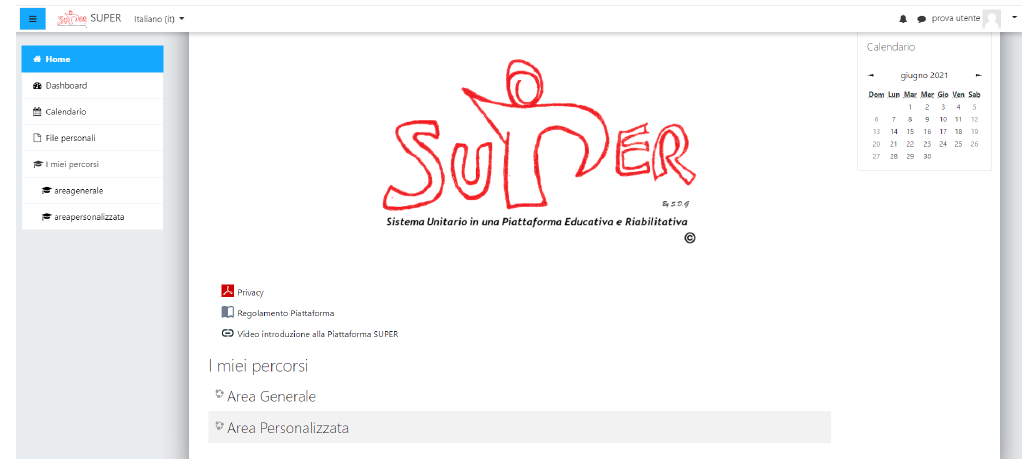
Figure 1. Screenshot of the SUPER homepage. The figure features the homepage of the SUPER platform, where users can access the General and Personalized Area.